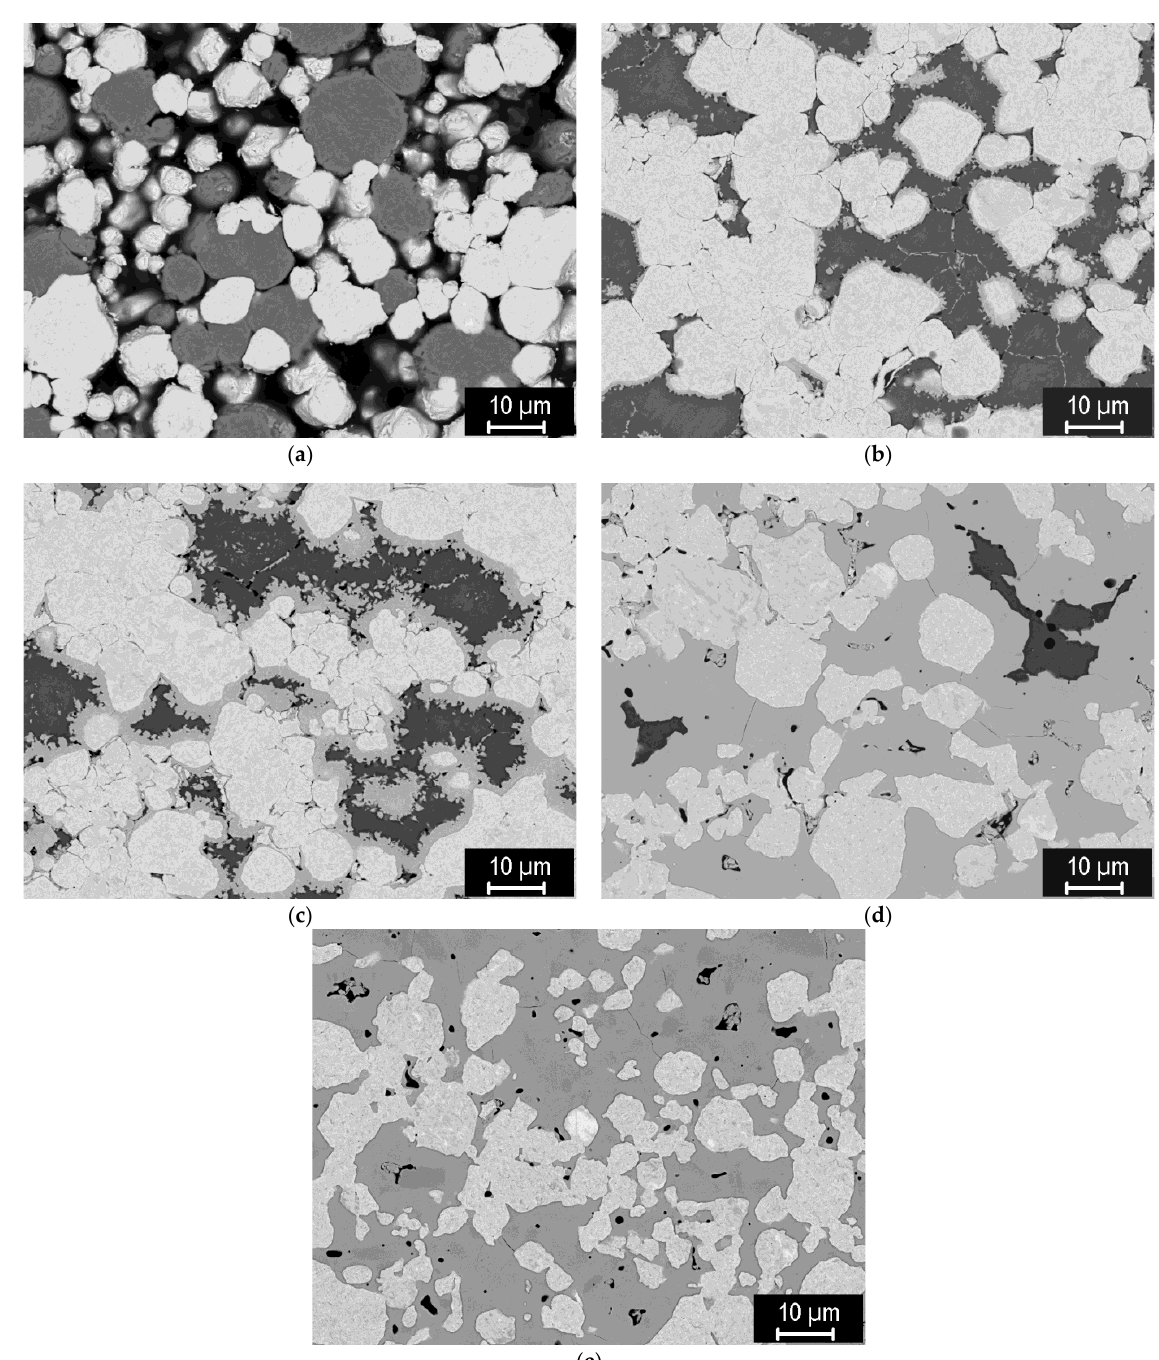
Figure 10. Microstructures of 75% W — 25% steel composites sintered at various temperatures: ( a )